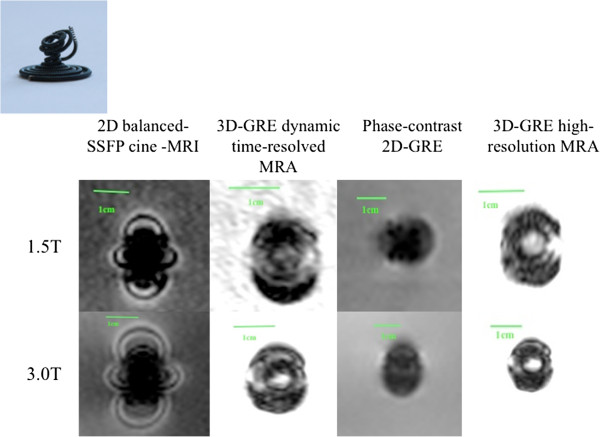
MR appearance of Nitocclud Embolization Coil (Device 10).